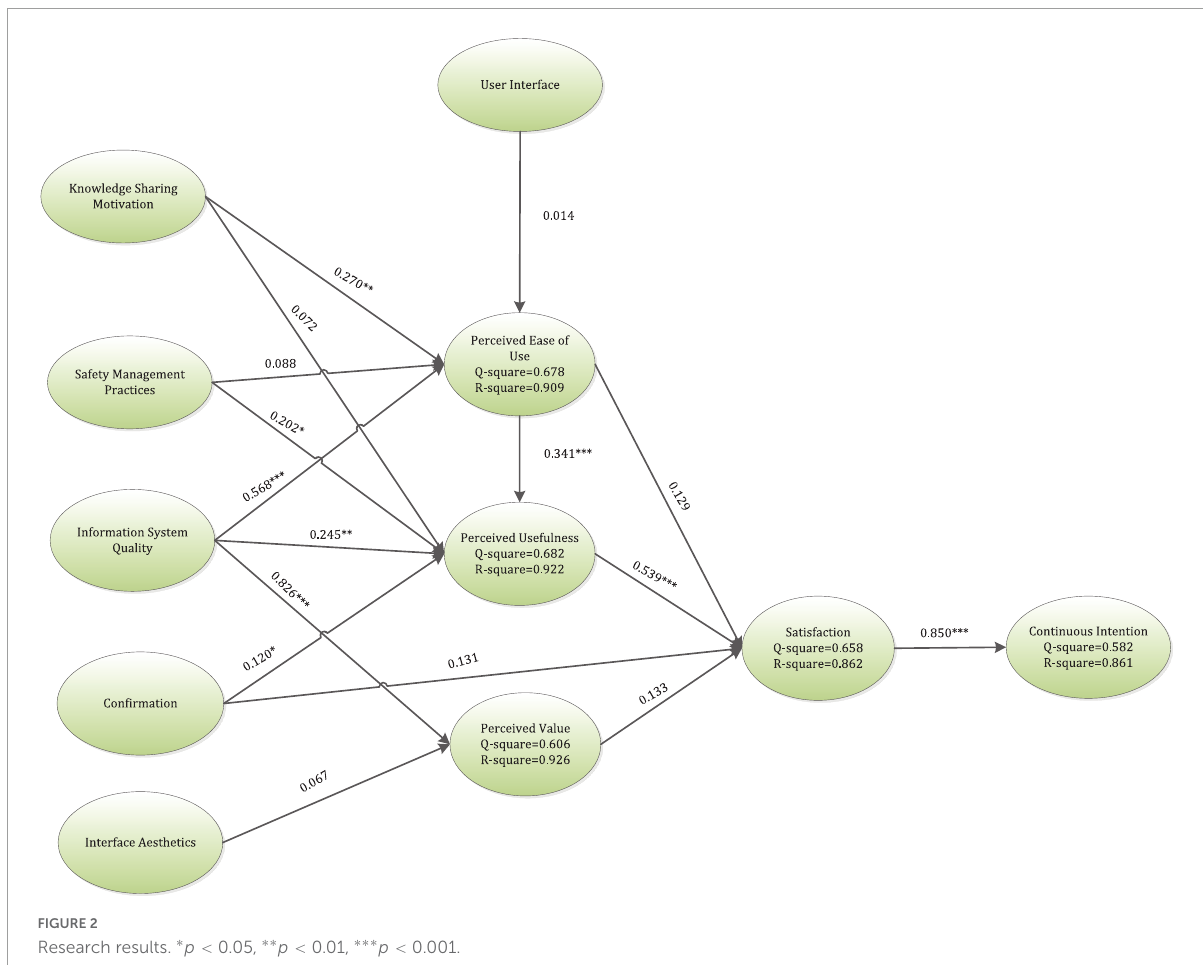
FIGURE2 Research results. ∗ p < 0.05, ∗∗ p < 0.01, ∗∗∗ p <